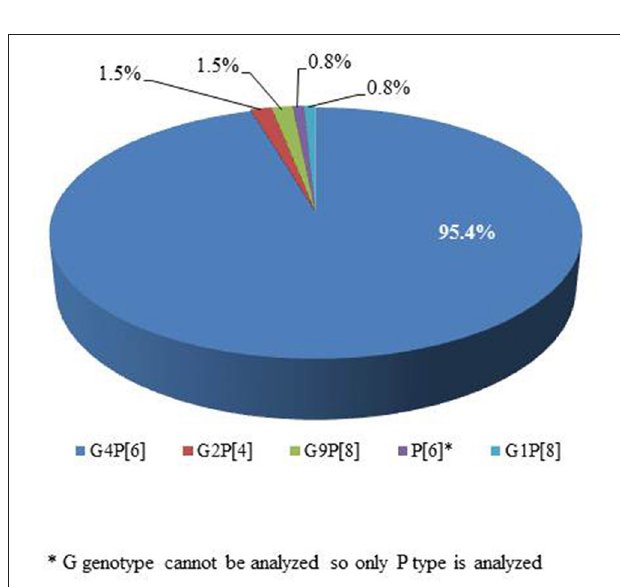
FIGURE 5 | Genotype distribution of positive rotavirus cases in a neonatal intensive care unit ( n = 131).